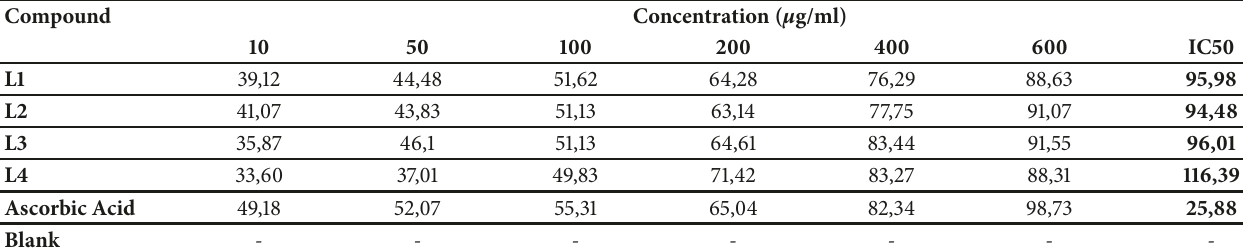
Table 3: The antioxidant activity of L1-L4 in